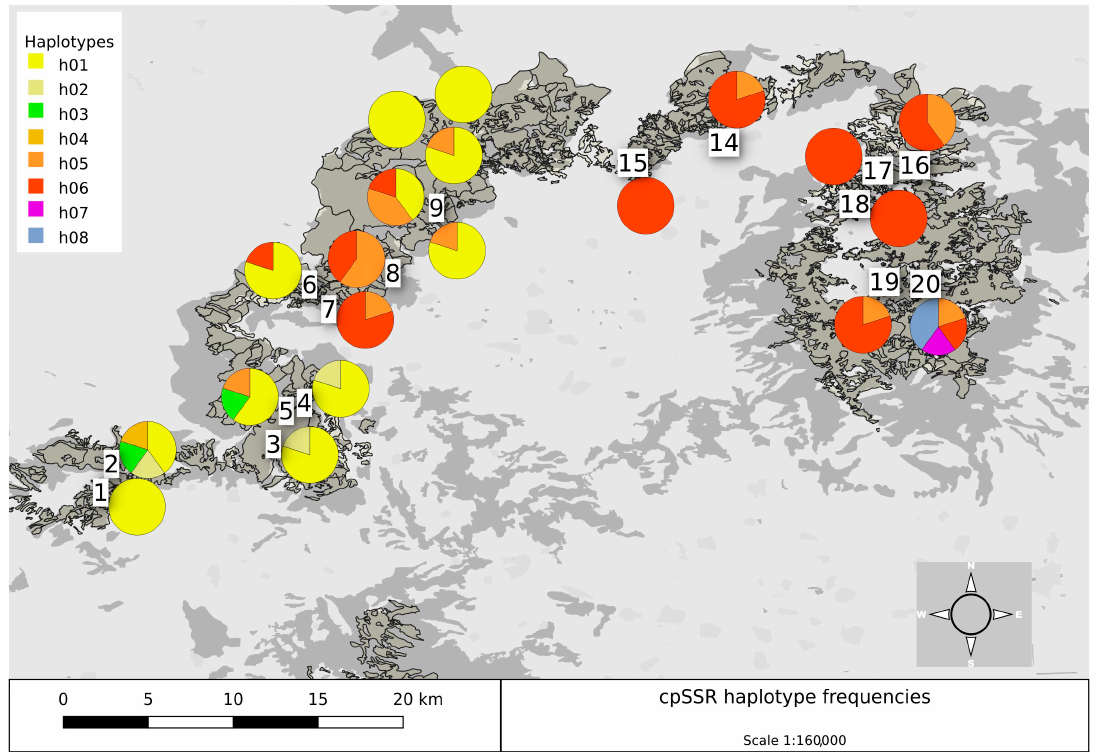
Figure 3. Map of the geographical distribution of the cpSSR beech haplotypes in the 20 plots of this study. Rare haplotypes were observed only in the southernmost plots of Mt. Voras (h02, h03, h04) and in plot 20 on Mt. Paiko (h07, h08). Genetic diversity differed largely within plots with the average number of haplotypes per plot being 2. While some plots were monomorphic, plots 2, 5, 13 and 20 carried more than two haplotypes and therefore demonstrated the highest diversity at cpSSR markers (Table 3). Differentiation among the plots was very high ( Φ pt = 0.794) since the largest part of the total genetic diversity of cpSSR haplotypes (79%) was among plots, as shown by the AMOVA, with diversity within plots being just 21% (Table 4). The Bayesian inference of the cpSSR haplotypes classified the trees into two genetic clusters corresponding to the groups seen in the hap- lotype network and their geographical coverage. Cluster 1 included trees that carried hap- lotypes belonging to the group of h01 located on the western side of the Almopia basin (Mt. Voras). Trees belonging to Cluster 2 carried h06, or one of the other haplotypes that belonged to this group, and were mainly found on the eastern part of the study area on Mt. Tzena, Mt. Pinovo, Mt. Paiko and Loutraki on the western side (Figure 4).